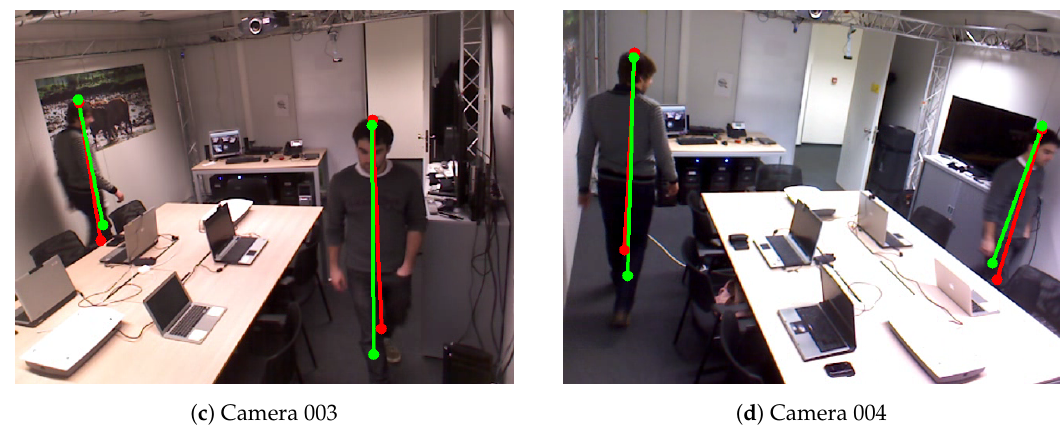
Figure 11. Example of detected the bottom and top positions of the pedestrians of Camera Network 7. Red color represents detected positions by the human pose estimation method. Green color represents the detected reprojected positions. Table 11. Calibration results of camera calibration based on multiple walking people of the Camera Network 7. The extrinsic parameters was estimated based on the proposed method in Section 3.2 hip joints and the proposed method in Section 3.5 without both hip and feet information. δ u ( rr ) denotes the relative reprojection error. Single Person Multiple People